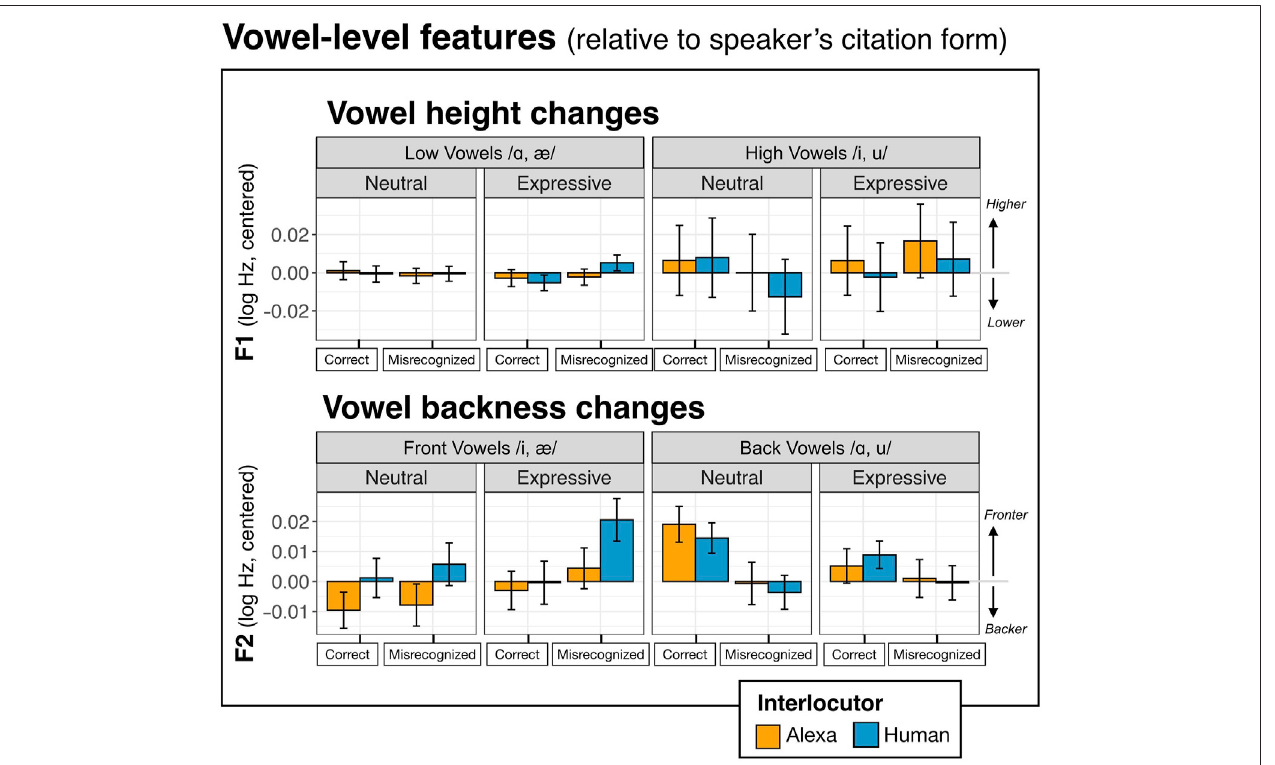
FIGURE 4 | Mean acoustic changes from speakers ’ citation form productions to the interaction with the Interlocutors (Alexa vs. human) for vowel duration (milliseconds, ms), F1 (log Hertz, Hz), and F2 (log Hertz, Hz). Formant plots are additionally faceted by Vowel Category: F1 (by vowel height: low vs. high vowels) and F2 (byvowelbackness:frontvs.backvowels).The x -axisshowsStagedMisunderstandingCondition(correctlyheardvs.misrecognized),whileExpressivenessConditionis faceted.Valueshigherthan0.0indicateanincrease(relativetospeakers ’ citationform),whilevalueslowerthan0.0indicatearelativedecrease.Errorbarsdepictthe standard error.